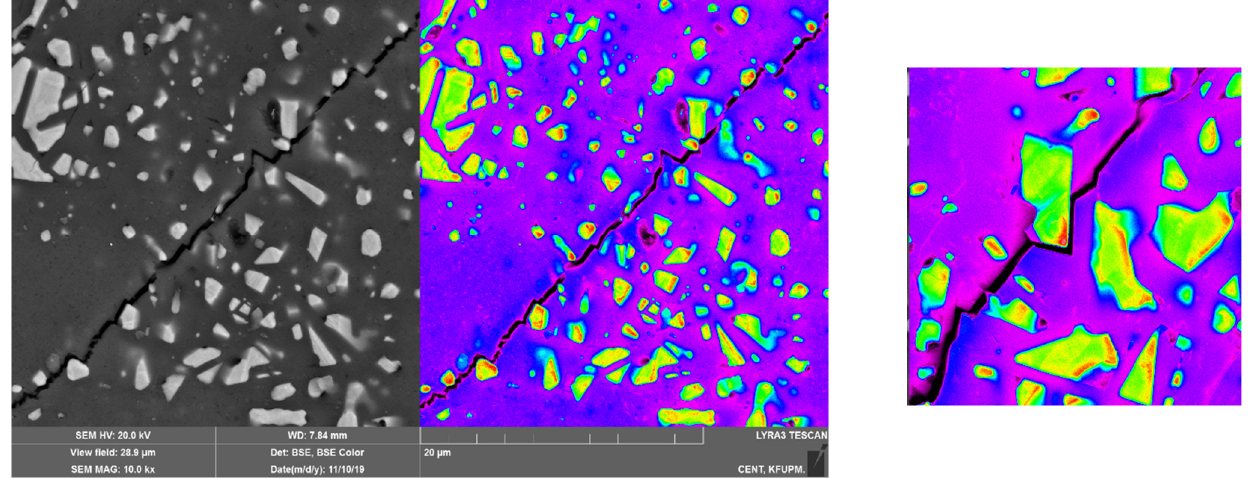
Figure 9. FESEM image showing crack propagation within the 20% Ni/Ca-α-SiAlON composite.